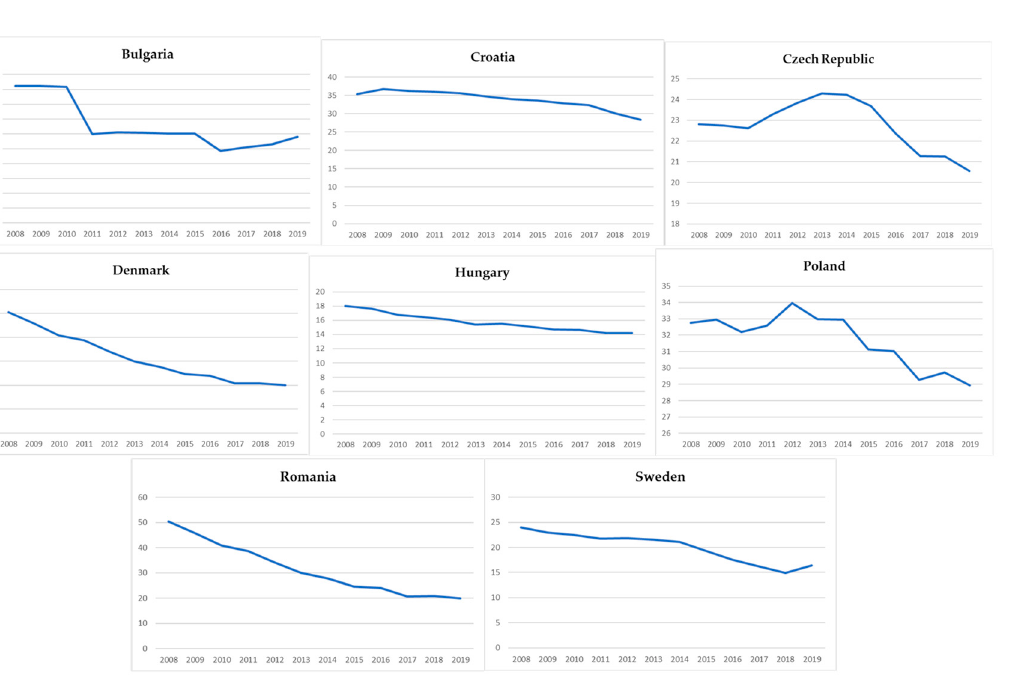
Table 1. Variables description.